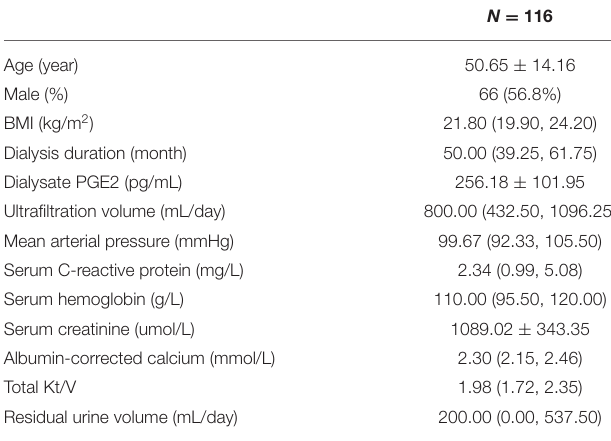
TABLE 2 | Patients’ clinical